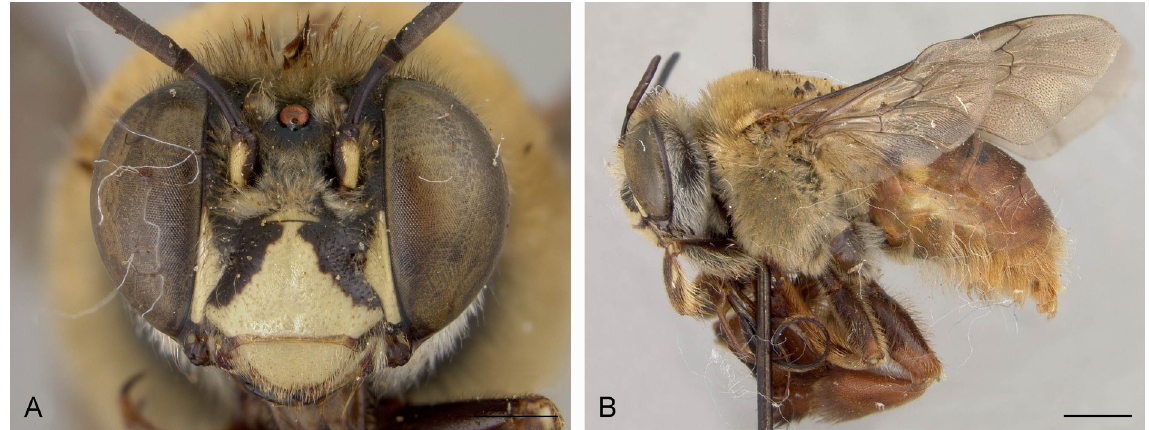
Fig. 7. Centris robusta Cockerell, 1949, holotype, ♂ (NMNH; USNM ENT 00534211). A . Frontal view. B . Habitus, lateral view. Scale bars: A = 1 mm; B = 2 Centris rufulina Cockerell, 1937 nom. rev.